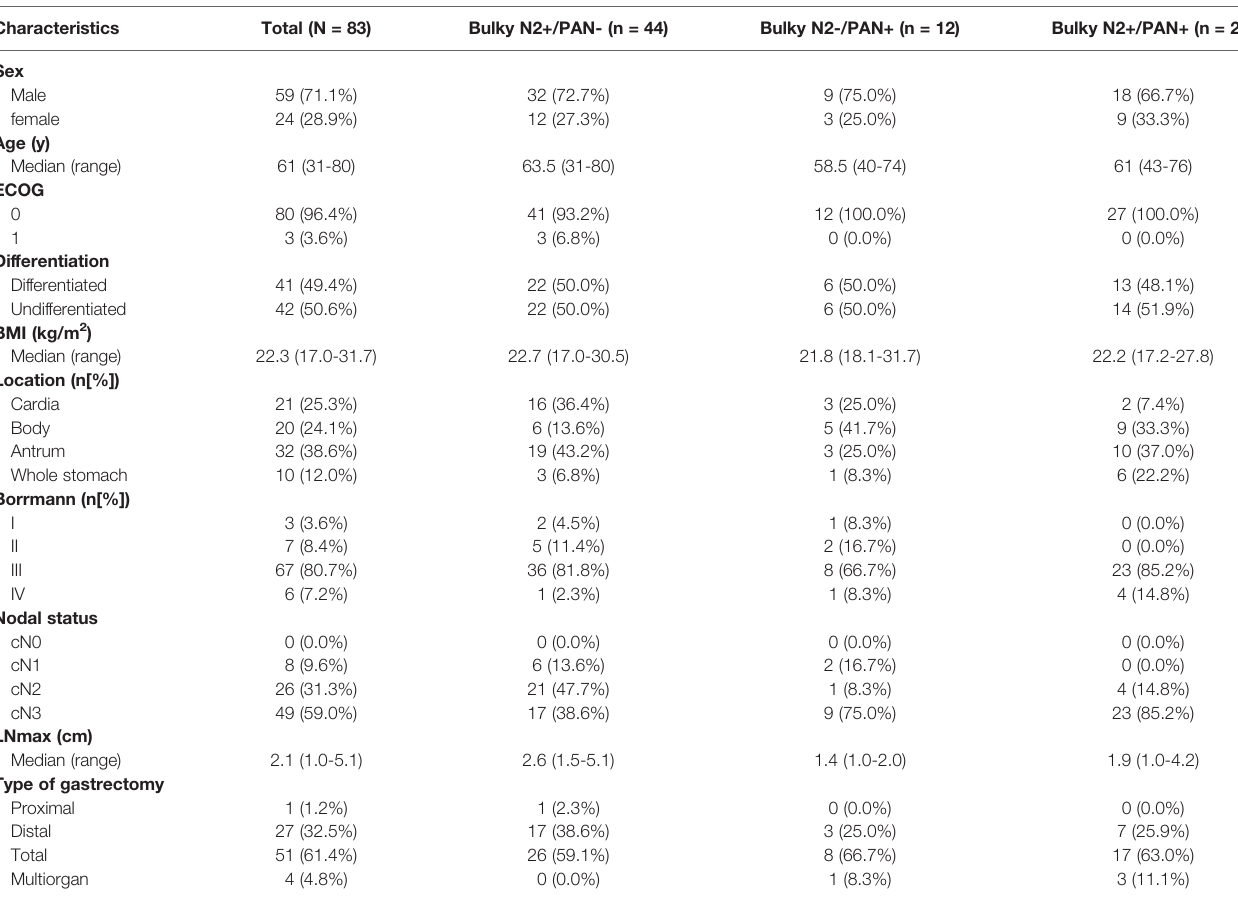
TABLE 1 | Characteristics of all enrolled